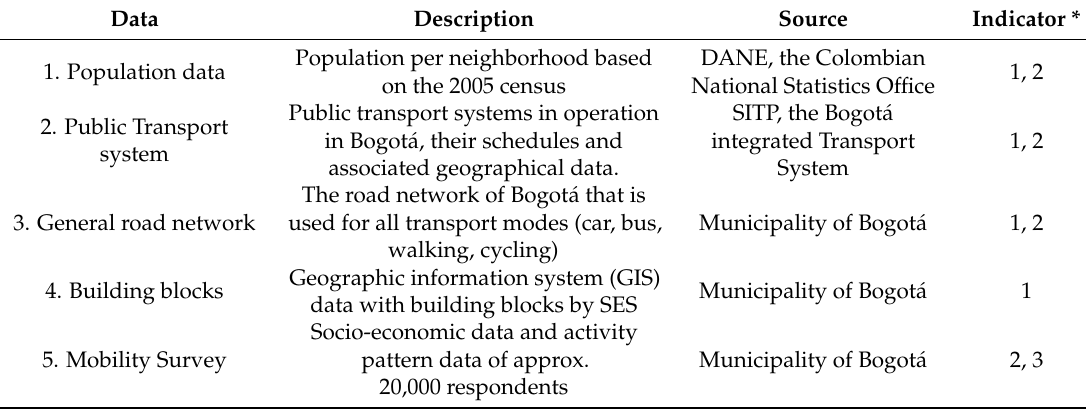
Table 2. Overview of data used. * Indicator 1 refers to SDG indicator 11.2; Indicator 2, proposed by the authors, refers to the potential accessibility indicator; Indicator 3, proposed by the authors, refers to the actual travel